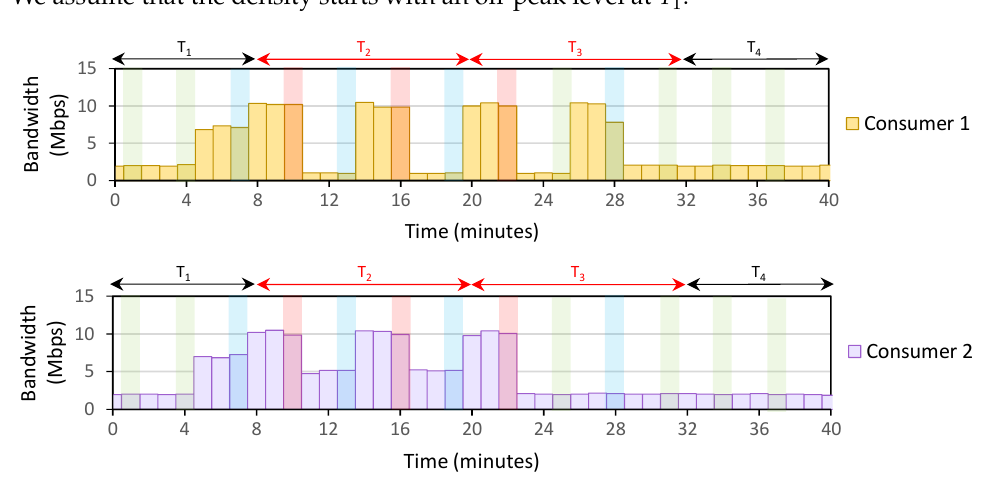
Figure 5. An example of a traffic pattern that only follows Rule 1 (Scenario 1). Green, blue, and red bars point to density changes in off-peak, normal, and peak. The red color of T n indicates the point-of-interest timeslot, where we sent the 900 MB data.